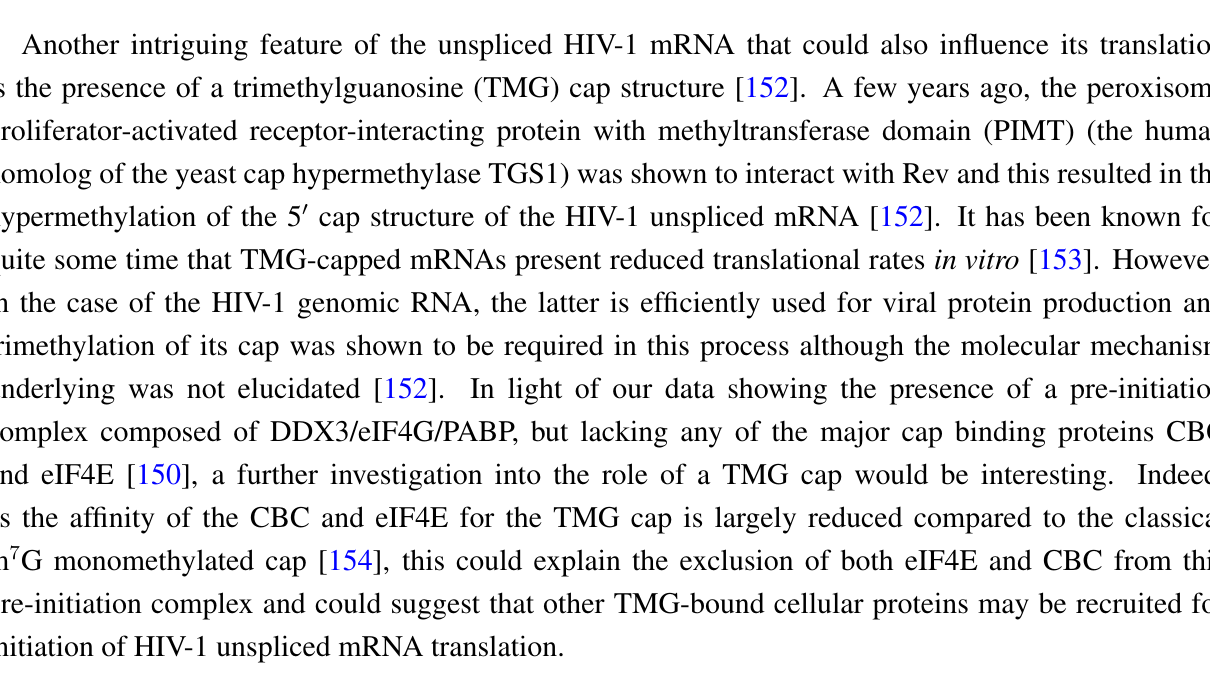
Figure 2. DDX3-mediated translation of the HIV-1 genomic RNA. In the absence of DDX3, the TAR RNA motif impedes binding of the eIF4F holoenzyme to the cap. Thus, DDX3 binds the viral 5 ′ -UTR to nucleate formation of a pre-translation initiation complex that involves ATP-dependent unwinding of TAR and specific recruitment of translation initiation factors eIF4GI and PABP (and probably other unidentified cellular proteins). TAR unwinding renders the cap accessible for eIF4F binding and subsequent recruitment of the 43S pre-initiation complex. It is possible that such a pre-translation initiation step driven by DDX3 occurs compartmentalized in RNA granules (in